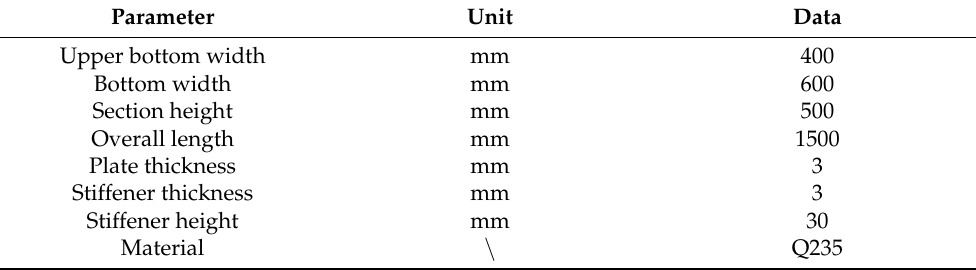
Table 1. Main parameters of box girder